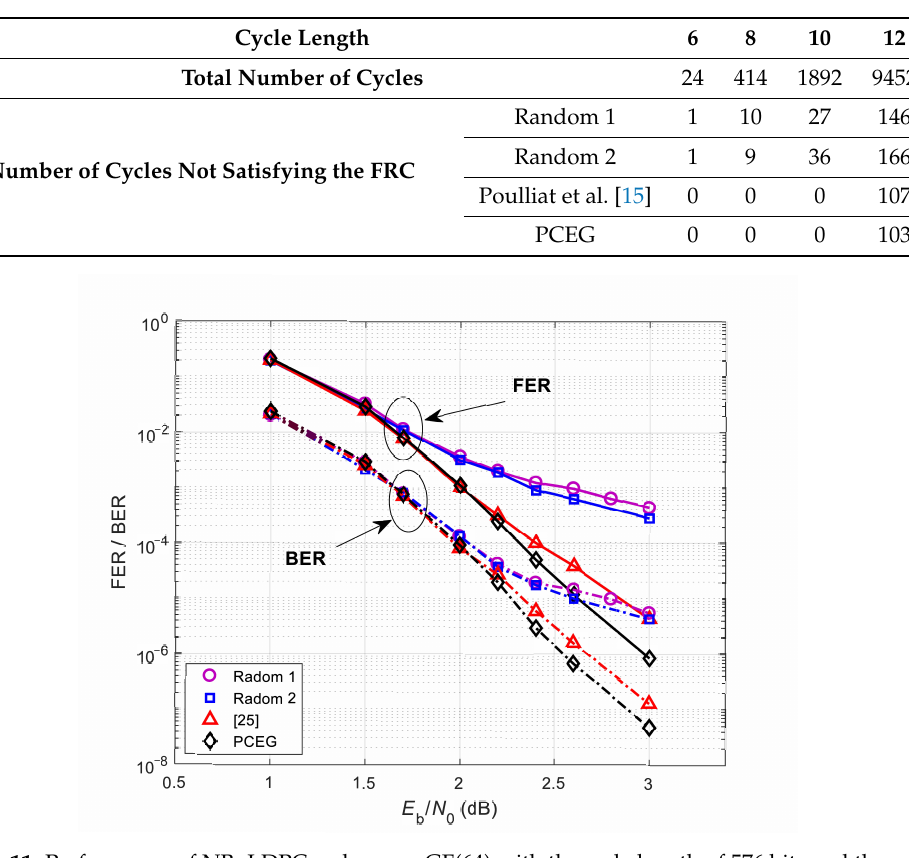
Table 4. Cycle distributions of NB-LDPC codes over GF(64) with the code length of 576 bits and the code rate of 3/4.